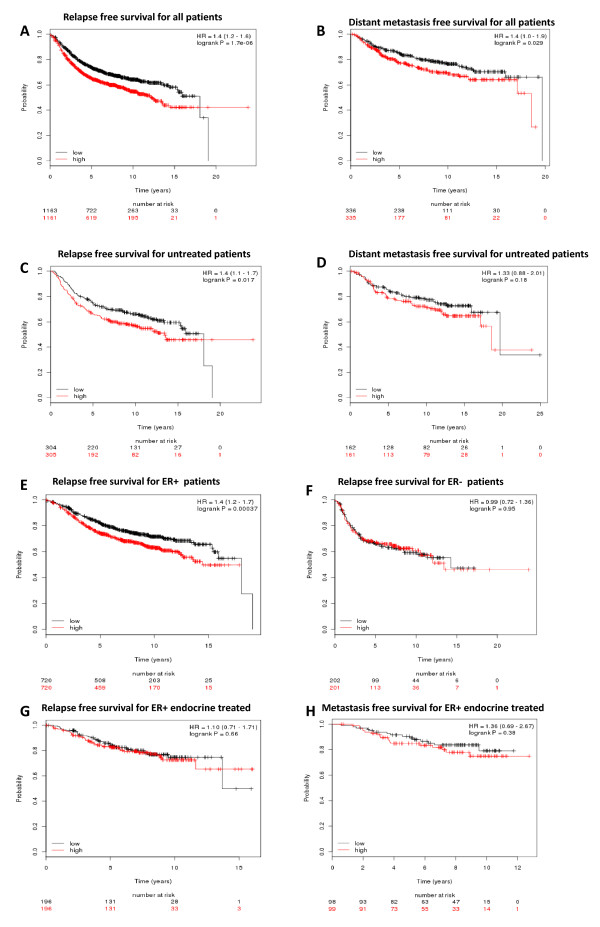
Kaplan-Meier survival plots demonstrate the prognostic relevance of S100P overexpression on patient survival. A) Overexpression of S100P is predictive of lower relapse free survival (P = 1.76e-6) for all patients; B) overexpression of S100P is correlated with decreased distant metastasis free survival (P = 0.029); C) Untreated breast cancer patients had lower relapse free survival if their tumors overexpressed S100P (P = 0.017); D) Weak correlation between the metastasis free survival and overexpression of S100P (P = 0.18); E) Higher level of S100P expression is predictive of poor relapse free survival for ER positive breast cancer patients (P = 0.00037); F) S100 overexpression is not associated with survival of ER negative breast cancer patients; G) S100 overexpression is not statistically significant for prognosis of ER positive endocrine treated patients; H) Overexpression of S100P is not predictive of metastasis-free survival of ER positive endocrine treated patients.